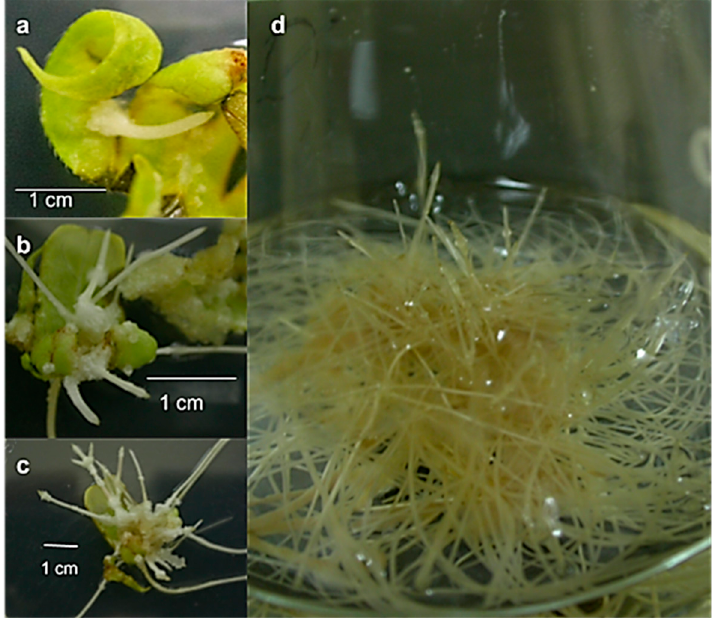
Figure 5. Hairy roots from Helianthella quinquenervis in hormone-free MS medium at ( a ) 12 d; ( b ) 20 d; ( c ) 30 d; ( d ) 90 d after transformation.